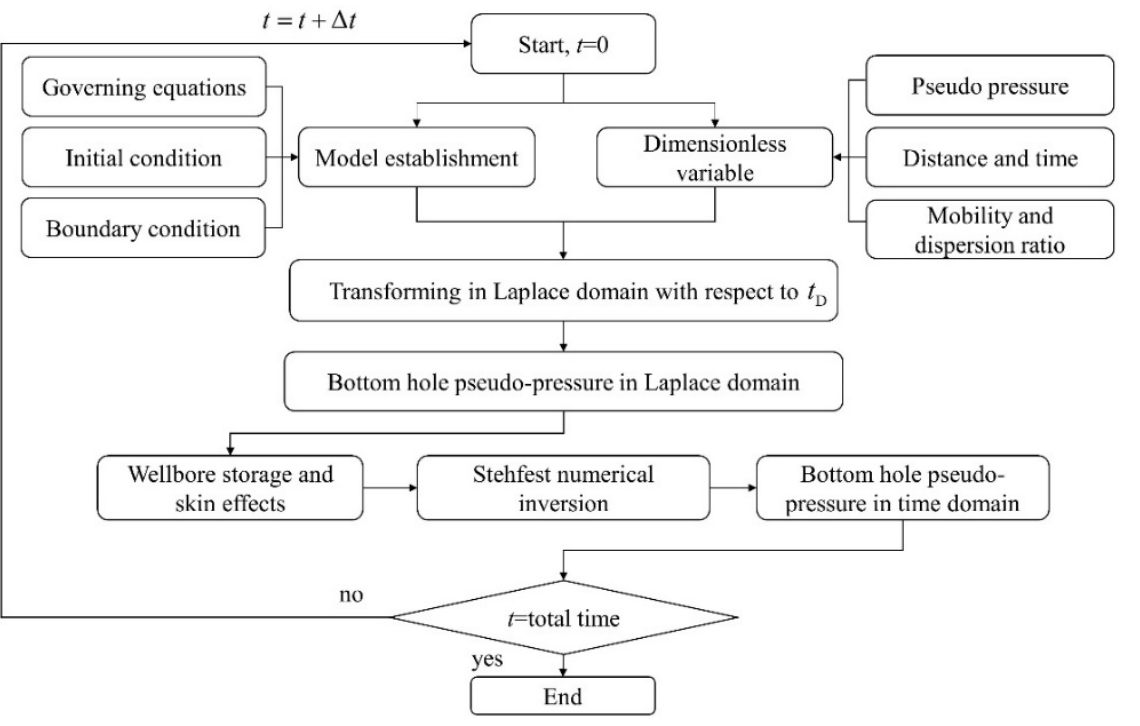
Figure 3. The solution procedure for bottom − hole pressure for vertical and horizontal wells.